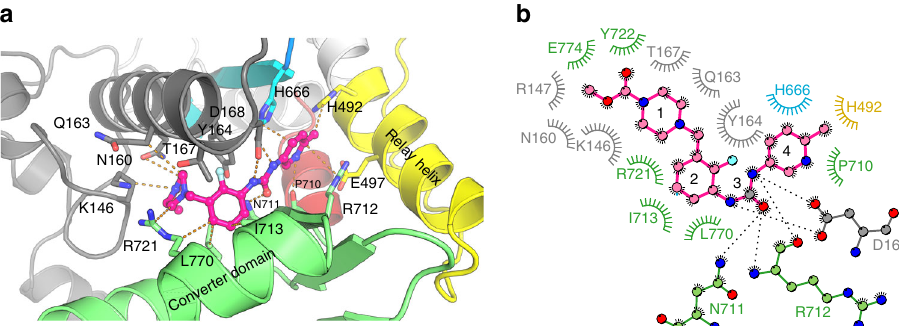
Fig. 3 The OM PPS binding site in the cardiac myosin motor domain. Ribbon a and diagram b representations of the most extensive interactions found in the OM “ PPS ” binding pocket. The different regions of the OM molecule are indicated with numbers: 1 carboxymethyl-piperazine; 2 fl uoro-benzyl ring; 3 carbamoyl-amino linker; 4 methyl-pyridinyl